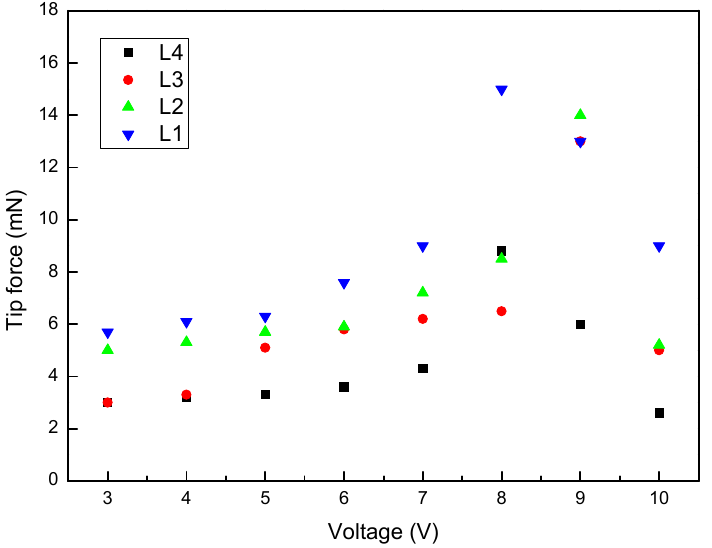
Figure 7. Tip forces of the IPMCs with various lengths under different voltages [28].